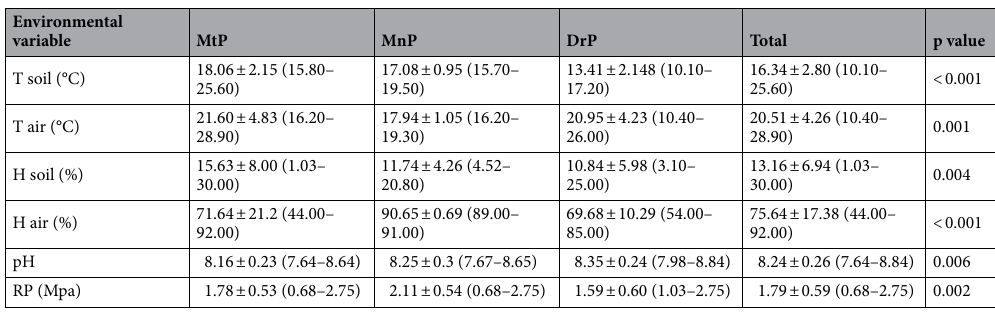
Table 2. Mean ± standard deviation (range) of the environmental variables for the different categories of managed green areas. The p value represents the significance level of the global one-way analysis of variance performed separately for each